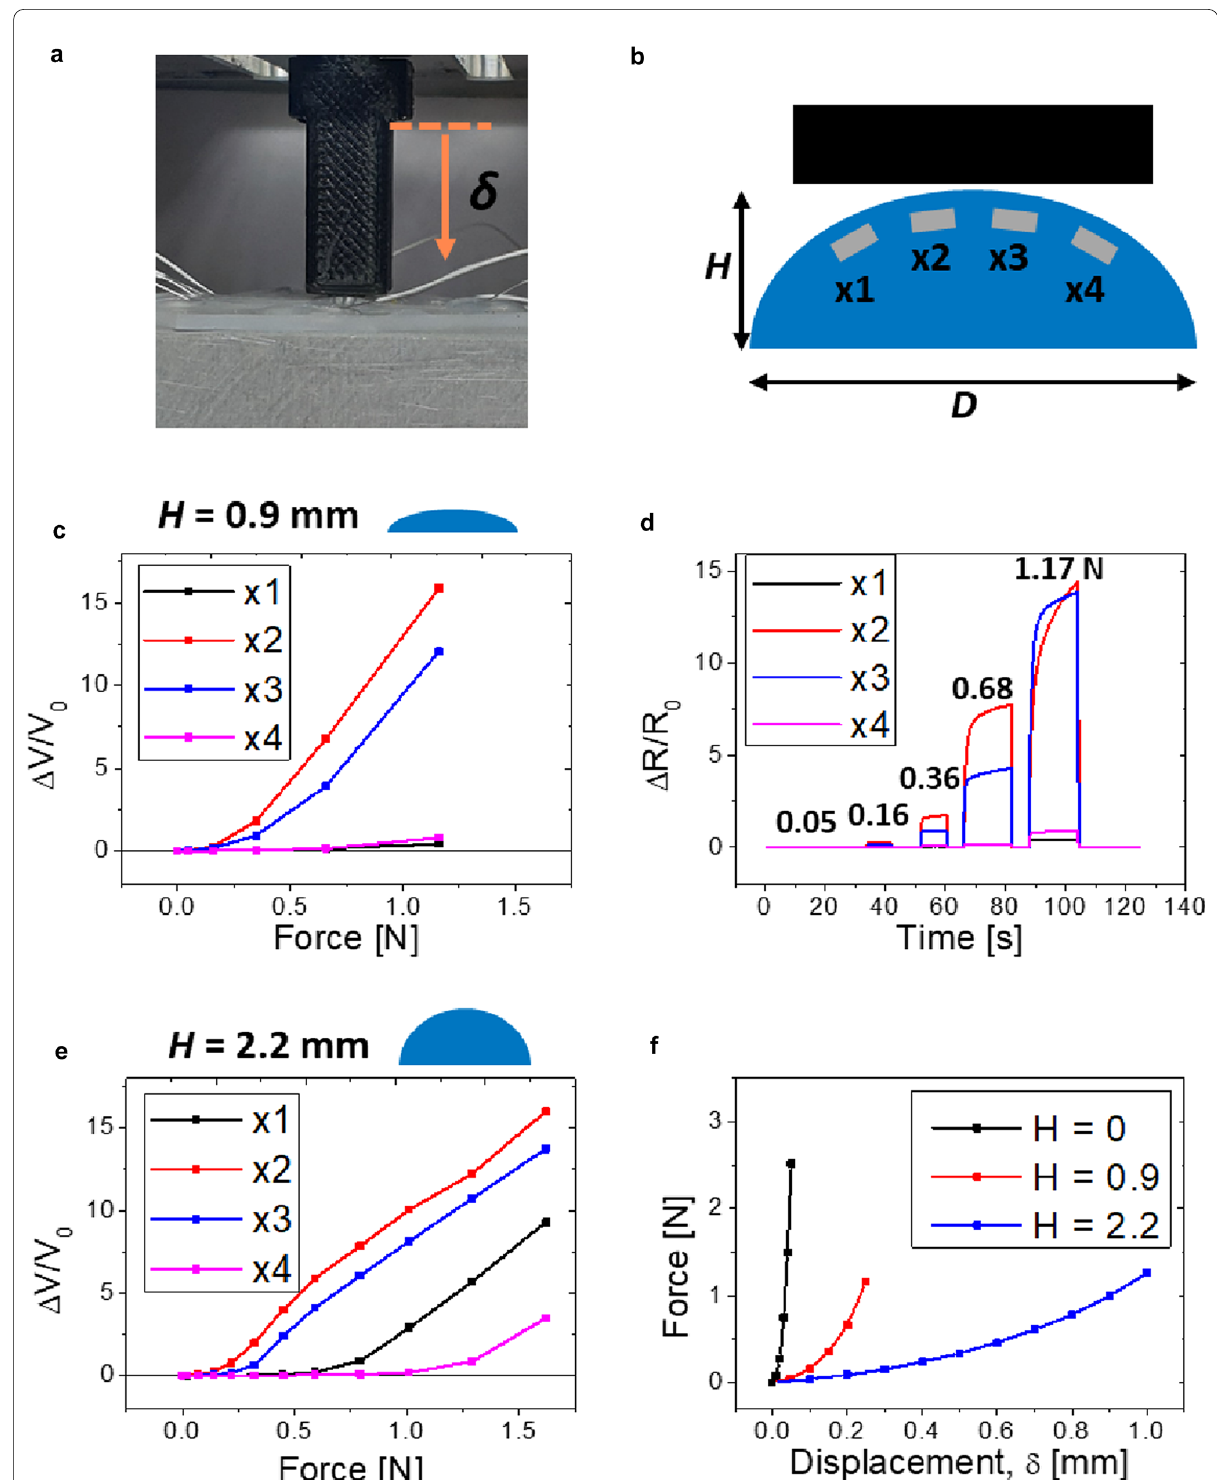
Fig. 4 Performance characterization. a Experimental setup. b Schematic view of the sensor. (x1–x4: labels for each LM microchannel, H : height of the dome, and D : diameter of the dome) c Response of the sensor with the dome height ( H ) of 0.9 mm to normal directional force. d Real-time response to various loadings e Response of the sensor when H is 2.2 mm. f Sensitivity to the displacement according to the height of the